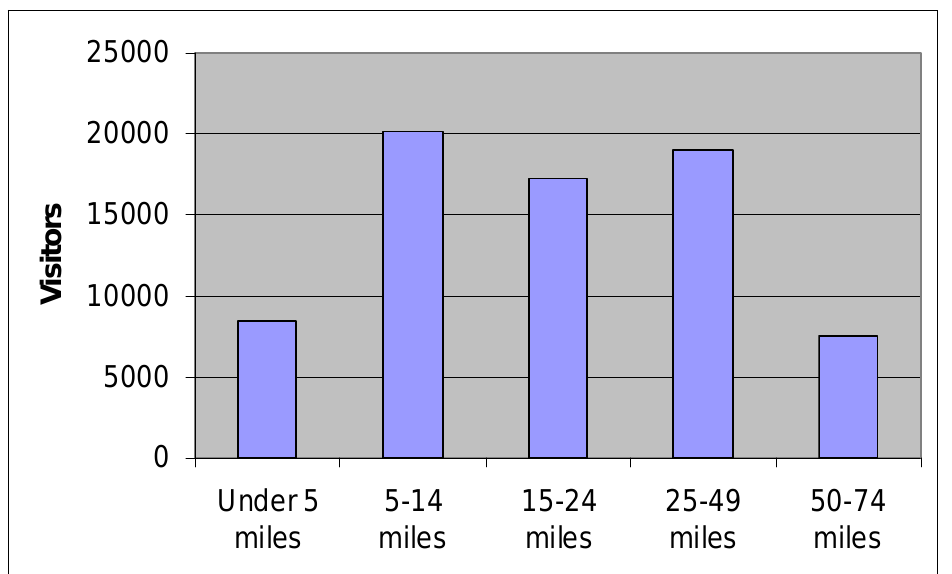
Figure 1: How far have you travelled to get to this property?